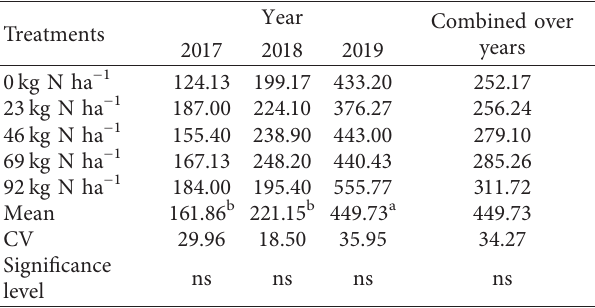
Table 4: Mean seed yield (kg ha − 1) of Chloris gayana in response to different N fertilizer levels.